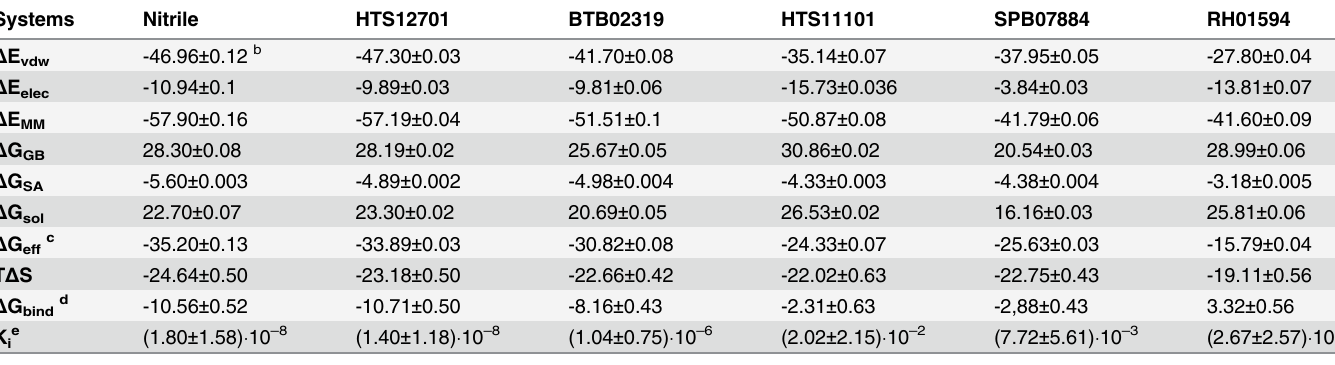
Table 3. Binding free energies and its components for the studied systems. a